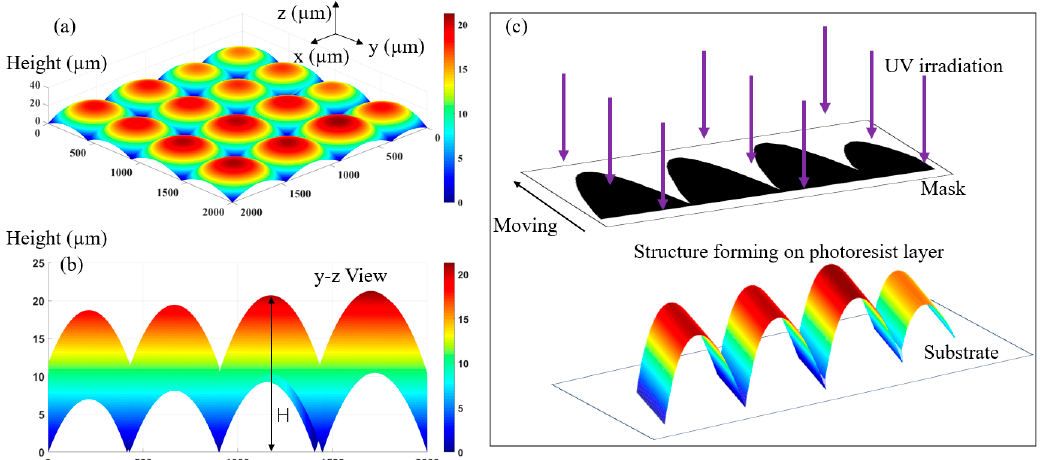
Figure 1. Exposure formation principle of multi ‐ focus MLA: ( a ) 3D profile of MLA; ( b ) Y–Z view; ( c ) Schematic diagram of moving mask exposure.